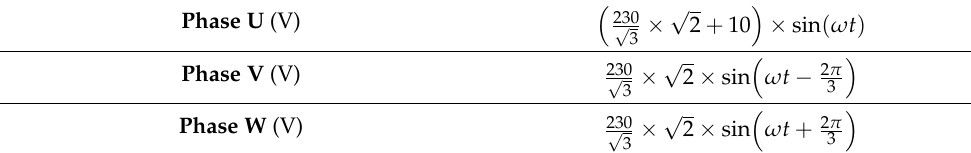
Figure 5. Equivalent electric circuit. Table 2. Supply voltage